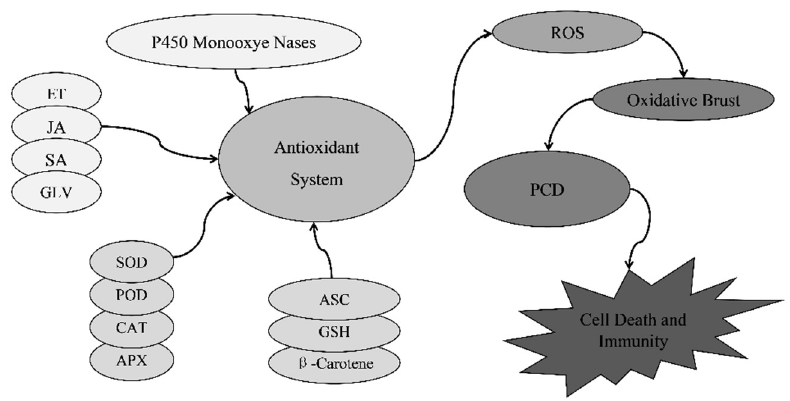
Figure 2. Mechanism of PCD in some rice lesion-mimicking mutations. ET: Ethylene; GLV: Green leaf volatiles; JA: Jasmonic acid; SA: Salicylic acid; SOD: Superoxide dismutase; CAT: Catalase; POD: Peroxidase; APX: Aseorbateperoxidase; ASC: Ascorbic acid; GSH: Glutathione; ROS: Reactive oxygen species; PCD: Programmed cell